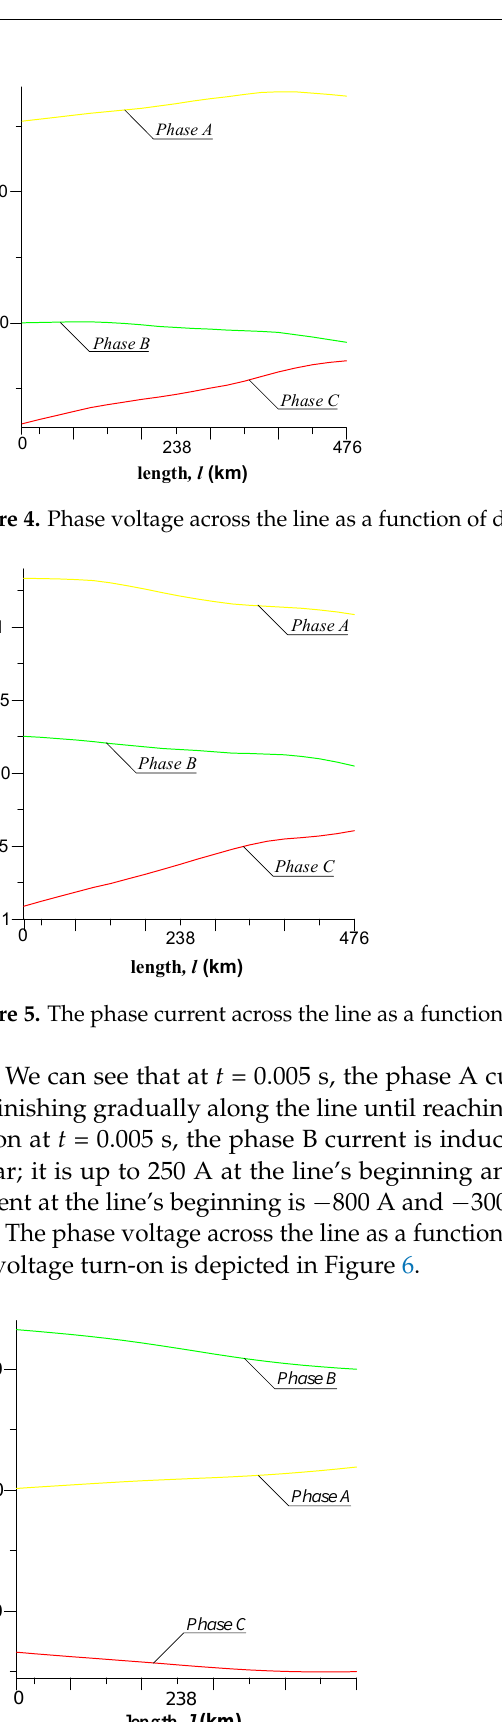
(56) where i * ( n ) —currents in the line discretization units. Equation (51) serves to compute i ( N ) in (50). This can give rise to the question of why these currents cannot be calculated based on (55) for n = N , cf. (56). The point is, (56) is a result of (55) by discretizing with the right-side derivative (see (54)), while (45) results from (46) by means of the central derivative, cf. (44). Therefore, integration in a sole sys- tem of discrete equations using different discretization types will be incorrect. The results of (56) are not employed in calculations and are of a purely informative nature. Equations (45), (46), (50)–(52), and (56) are integrated jointly, considering (13), (40), (47), and (53). 3. Results A computer simulation is undertaken to study transient electromagnetic processes in the power supply system. A simplified system diagram is shown in Figure 3, where the power line is connected to an asymmetrical load. Once a steady state is reached, a single-phase short-circuit occurs at point A at the line’s end. The line is turned on con- sidering the specific nature of controlled switching; in particular, the line is switched on at such a time instant that the instantaneous phase voltage is zero. Once the system be- comes stabilized at t = 0.08 s at the line’s end in phase A, a single-phase short-circuit to the earth is simulated in point A. The parameters of the calculation diagram in Figure 3 correspond to those of a real 750 kV, 476 km-long power supply line between the West Ukrainian switch station (Ukraine) and Albertirsha (Hungary). These are the parameters of the long power line: R 0 = 1.9∙10 −5 Ω/m, L 0 = 1.665∙10 −6 H/m, C 0 = 1.0131∙10 −11 F/m, g 0 = 3.25∙10 −11 Sm/m, C = 1.0122∙10 −12 F/m, g = 3.25∙10 −13 Sm/m, R Z = 5∙10 −5 Ω/m, M = 7.41∙10 −7 H/m. Equivalent load parameters are assumed, so that the power factor when transmitting energy is 0.95: R A = 420 Ω, R B = 350 Ω, R C = 310 Ω, L A = 0.82 H, L B = 0.75 H, L C = 0.63 H, C A = 0.000002 F, C B = 0.0000018 F, C C = 0.0000015 F. Computer simulation is conducted for the following volt-